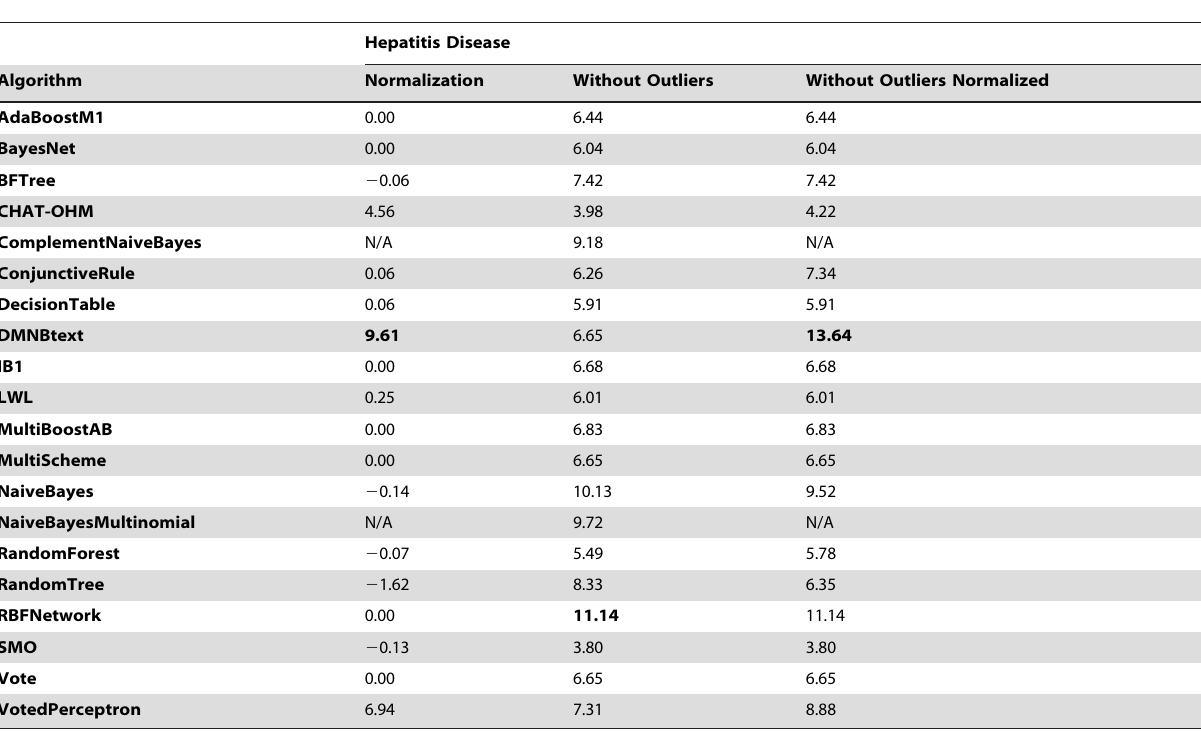
Table 10. Comparison of classification improvement (%) for hepatitis disease dataset.